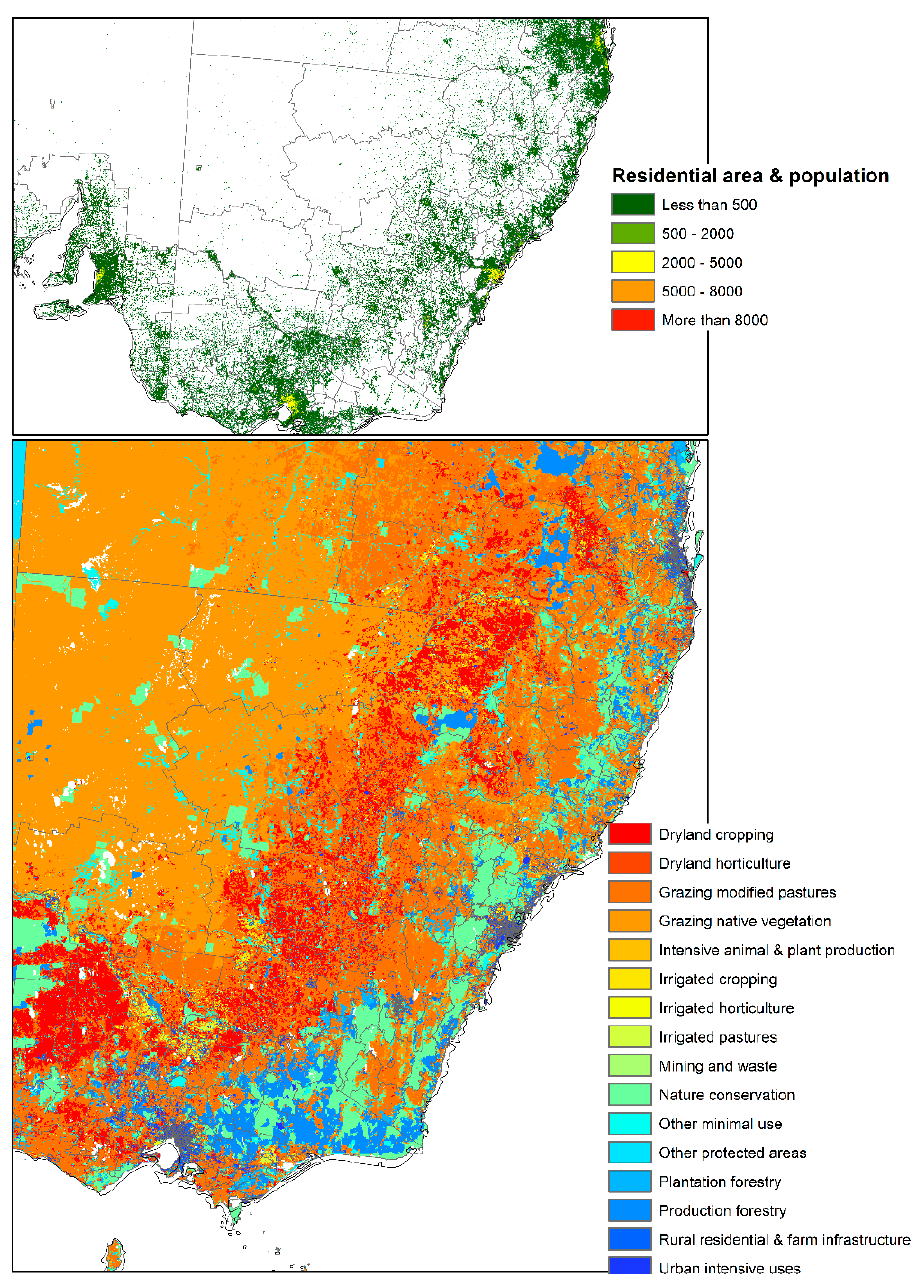
Figure 6. Current location of residential areas and its population, land use type and land management of eastern side of Australia. Data obtained from Australian Bureau of Agricultural and Resource Economics and Sciences available at: http://www.agriculture.gov.au/abares.